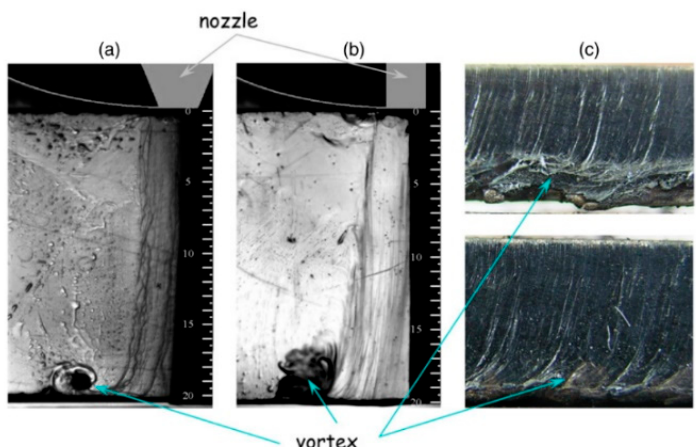
Figure 12. Vortex formed in the exit of the cut kerf using ( a ) converging, and ( b ) cylindrical nozzles. ( c ) Influence of their presence in the cutting quality during laser cutting of 20 mm thick mild steel using an oxygen jet (Supplying pressure p = 0.6 bar). Reprinted with permission from [37]. Copyright 2008 IOP Publishing.